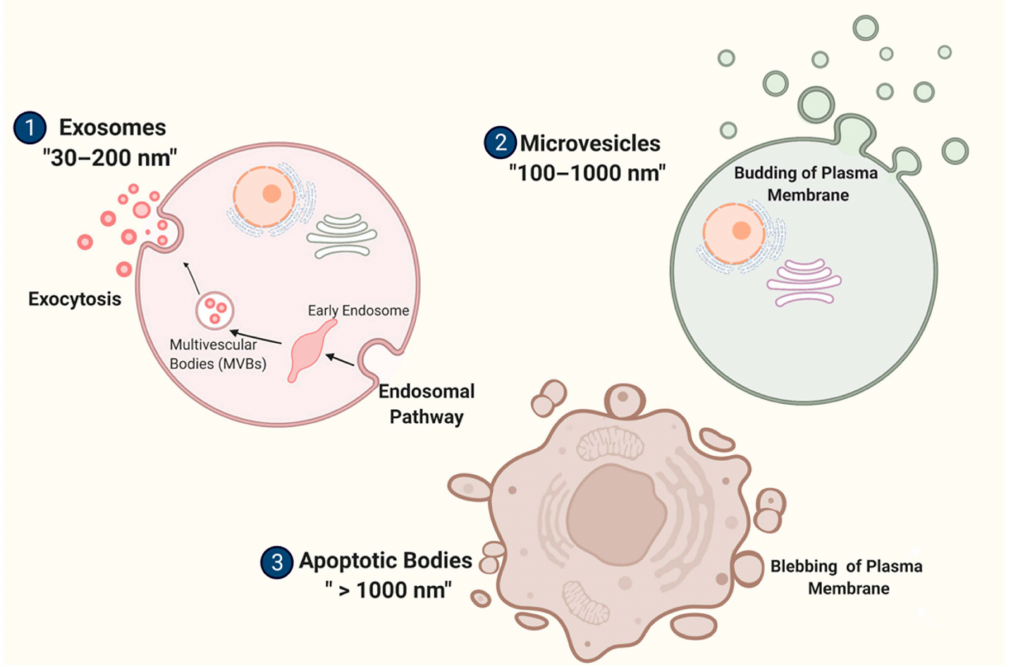
Figure 1. Classification of extracellular vesicles (EVs) with different discharge